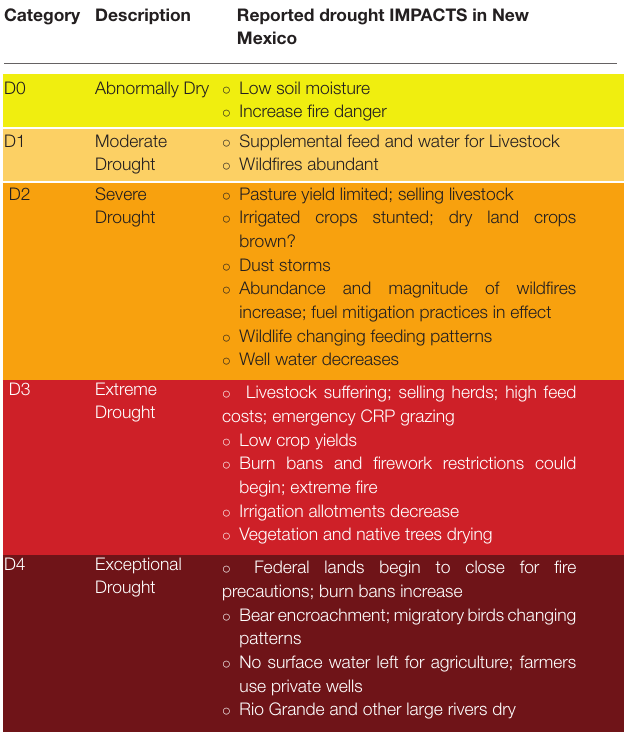
TABLE 6 | SDM categories and associated drought impacts for New Mexico (USDM, 2020b). Category